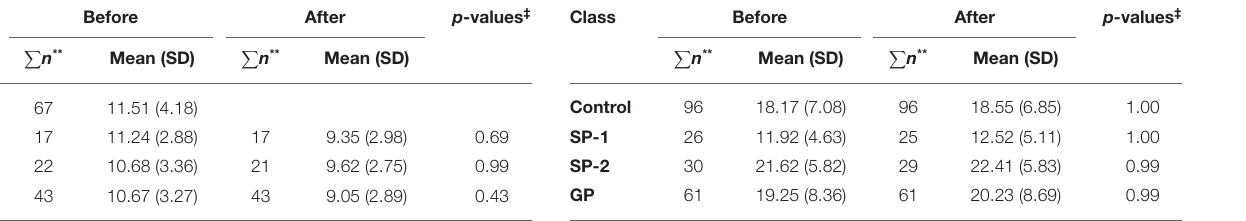
TABLE 4B | 5-week mean (SD) CO 2 TT scores before vs. after breathing exercises, by class * . Class Before After p- values